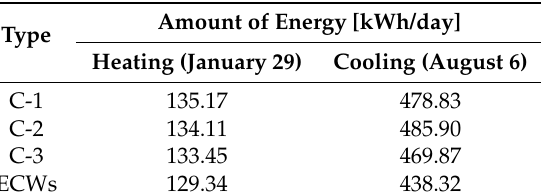
Table 6. Peak heating and cooling day energy consumption.